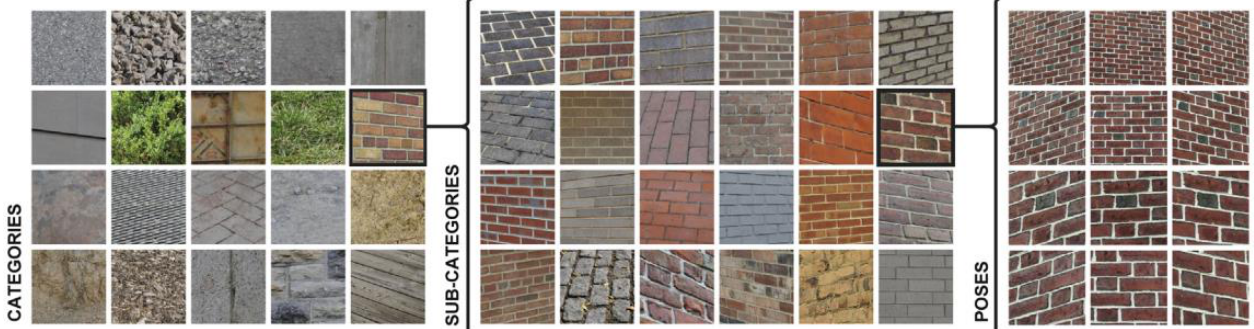
Figure 7. The construction material library [59].